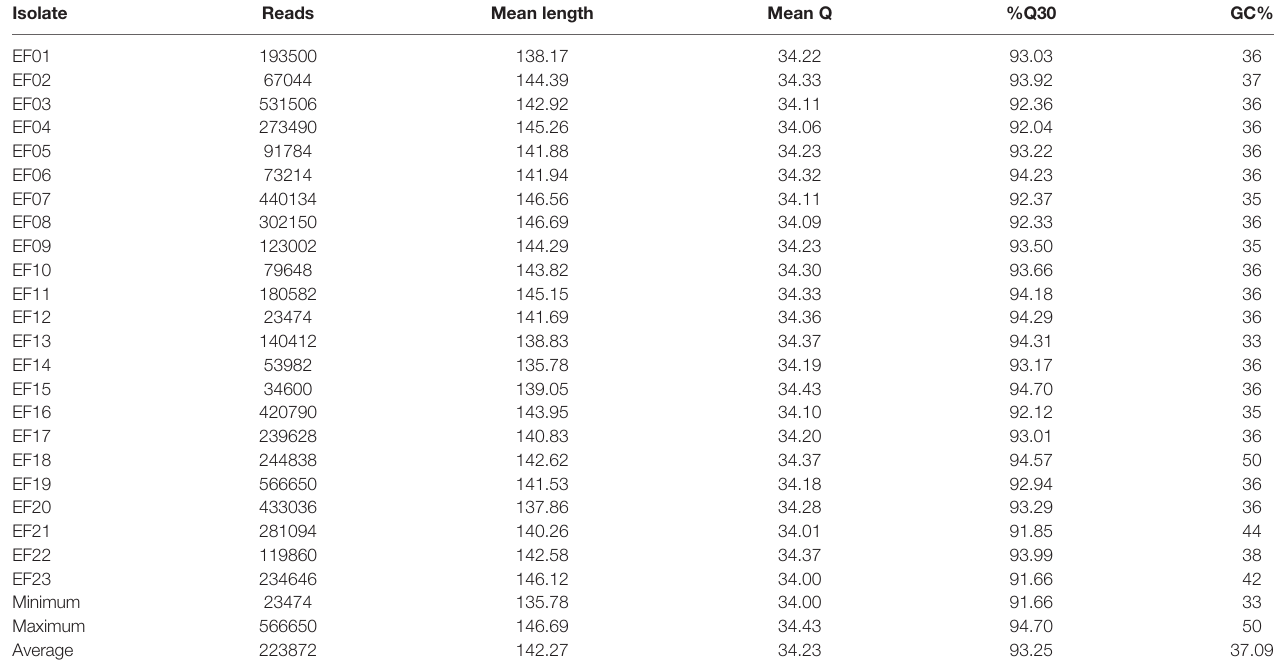
TABLE 1 | Quality control results of FastQC for the raw short-read next-generation sequencing data. Isolate